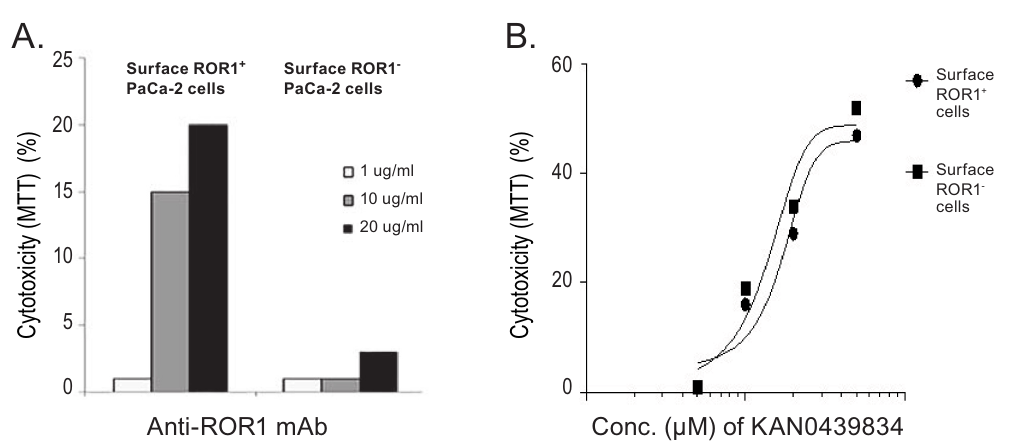
Fig 3. Cytotoxicity (MTT) of anti-ROR1 mAb and KAN0439834 in surface ROR1 positive (+) and negative (-) fractions of PaCa-2 cells. (A) Anti-ROR1 mAb (48 h) (B) KAN0439834 (48 h).